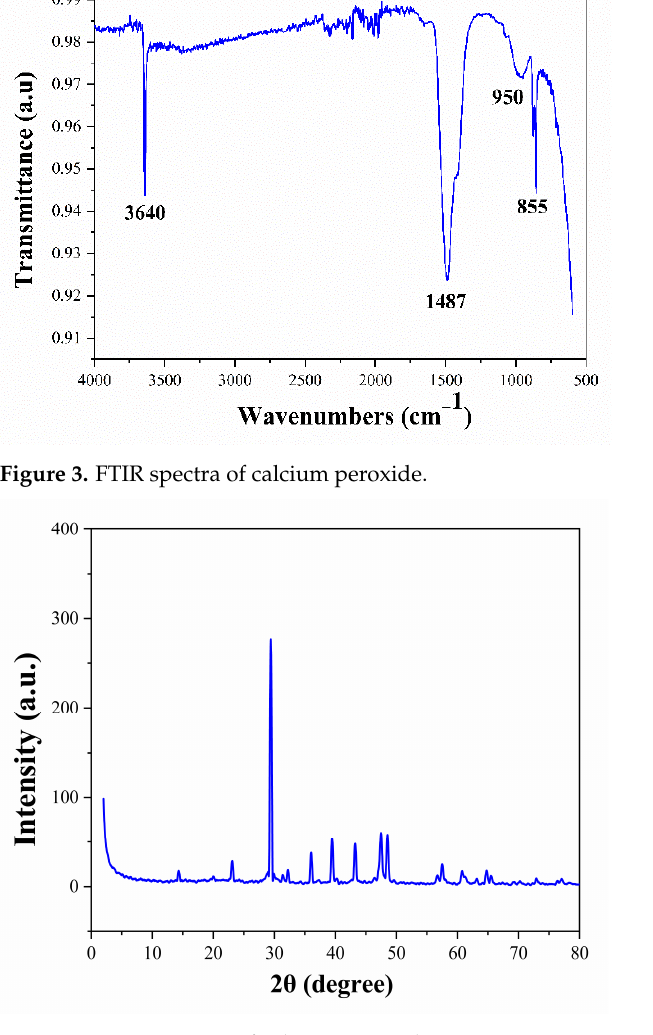
Figure 4. XRD patterns of calcium peroxide. Table 2. Purity of calcium peroxide.